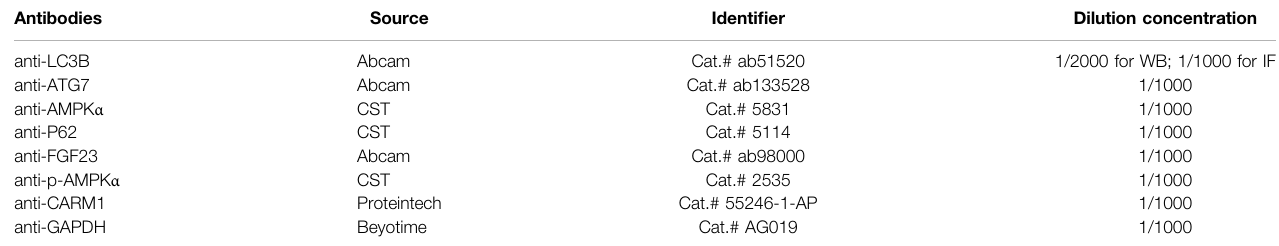
TABLE 2 | The antibodies used in this study are listed as follows.